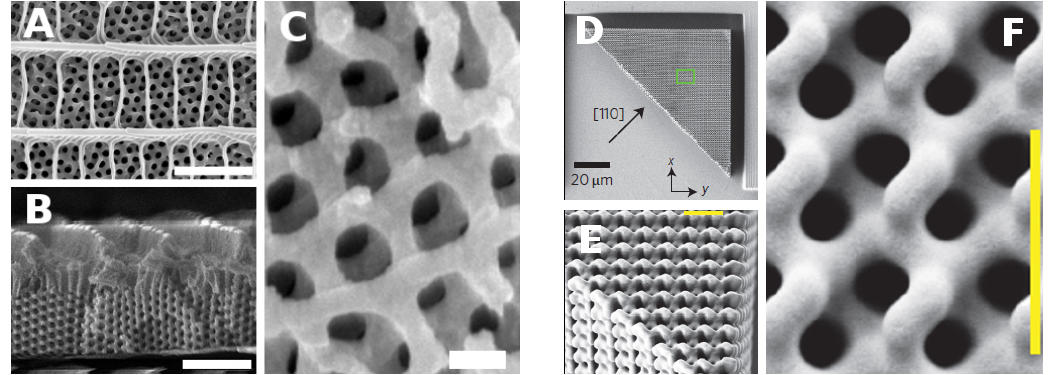
Figure 1. Biological and synthetic realisations of the single-gyroid photonic crystal. ( Left ) Porous chitin structure in the wing-scales of the butterfly, Callophrys rubi . ( A ) Top view of wing scale (scale bar: 2 µ m); ( B ) side view (scale bar: 2 µ m); ( C ) top view (scale 32 space group is around a « 0 . 3 µ m (images bar: 200 nm). The lattice parameter of the I 4 1 adapted from [14]). ( Right ) Chiral beam-splitter device based on the single gyroid structure with a “ 1 . 2 µ m, produced by galvo-dithered direct laser [15]; ( D ) perspective view of the prism-shaped device consisting of 80 2 ˆ 20 { 2 translational unit cells; ( E ) close-up with the scale bar being 2 µ m; ( F ) top view with the scale bar being 2 µ m (images adapted from [15], copyright 2013 Nature Publishing Group).